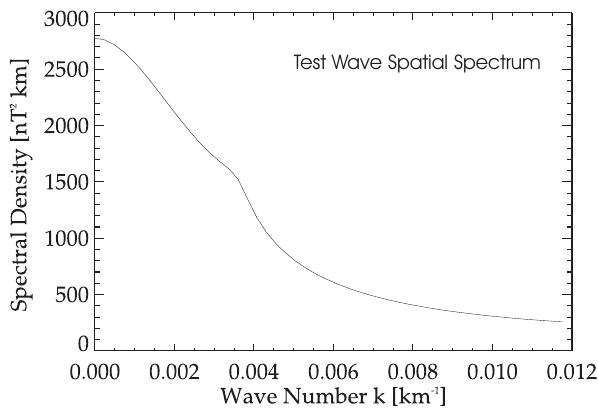
Fig. 2. Shell-max spatial spectral density distribution in logarith- mic presentation resulting from applying the wave telescope to the artificial data set.